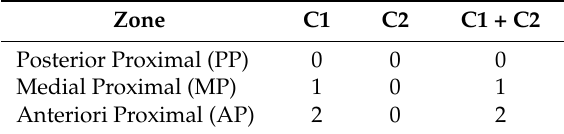
Table 6. The frequency of each zone showing statistically significant odds ratio (OR).